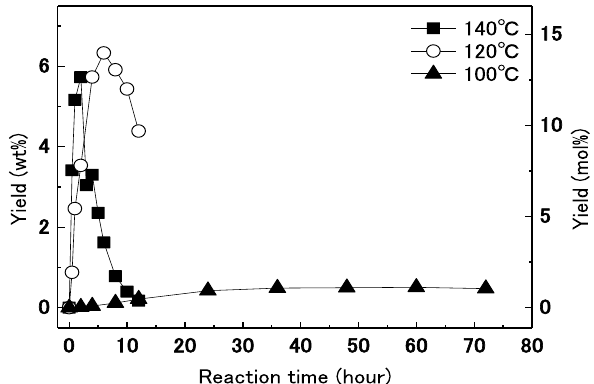
Figure 1. Change in yields of 5-hydroxymethylfurfural (5-HMF) with treatment time for dried wood (0.09 g) treated in [MIM]HSO 4 (3 g) at different